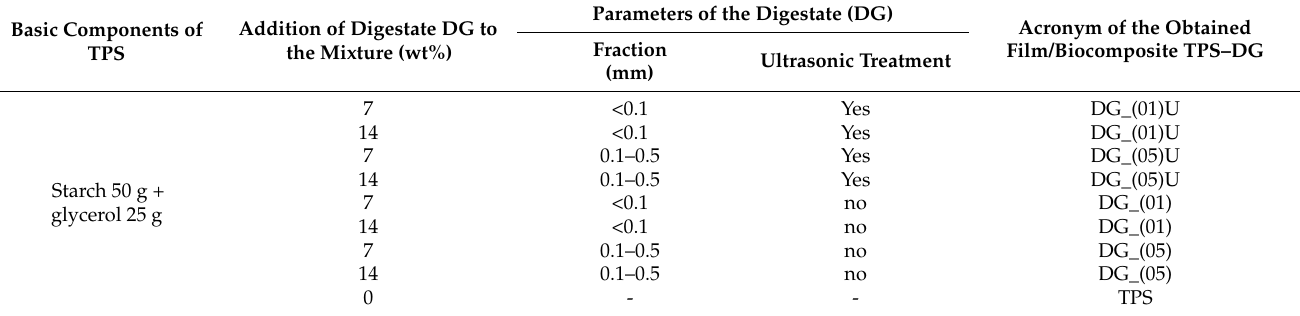
Table 1. Parameters of the mixture for TPS–DG